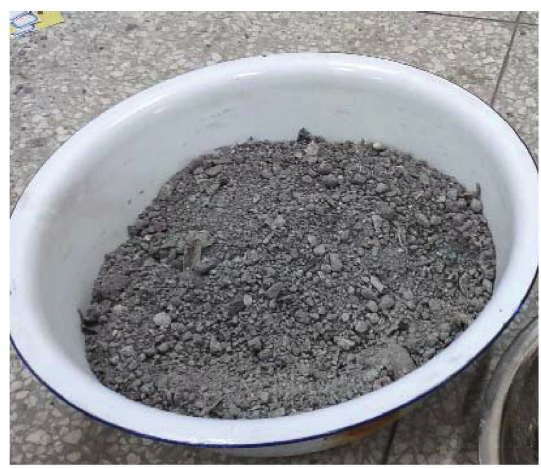
Figure 1: MSWI after being crushed.